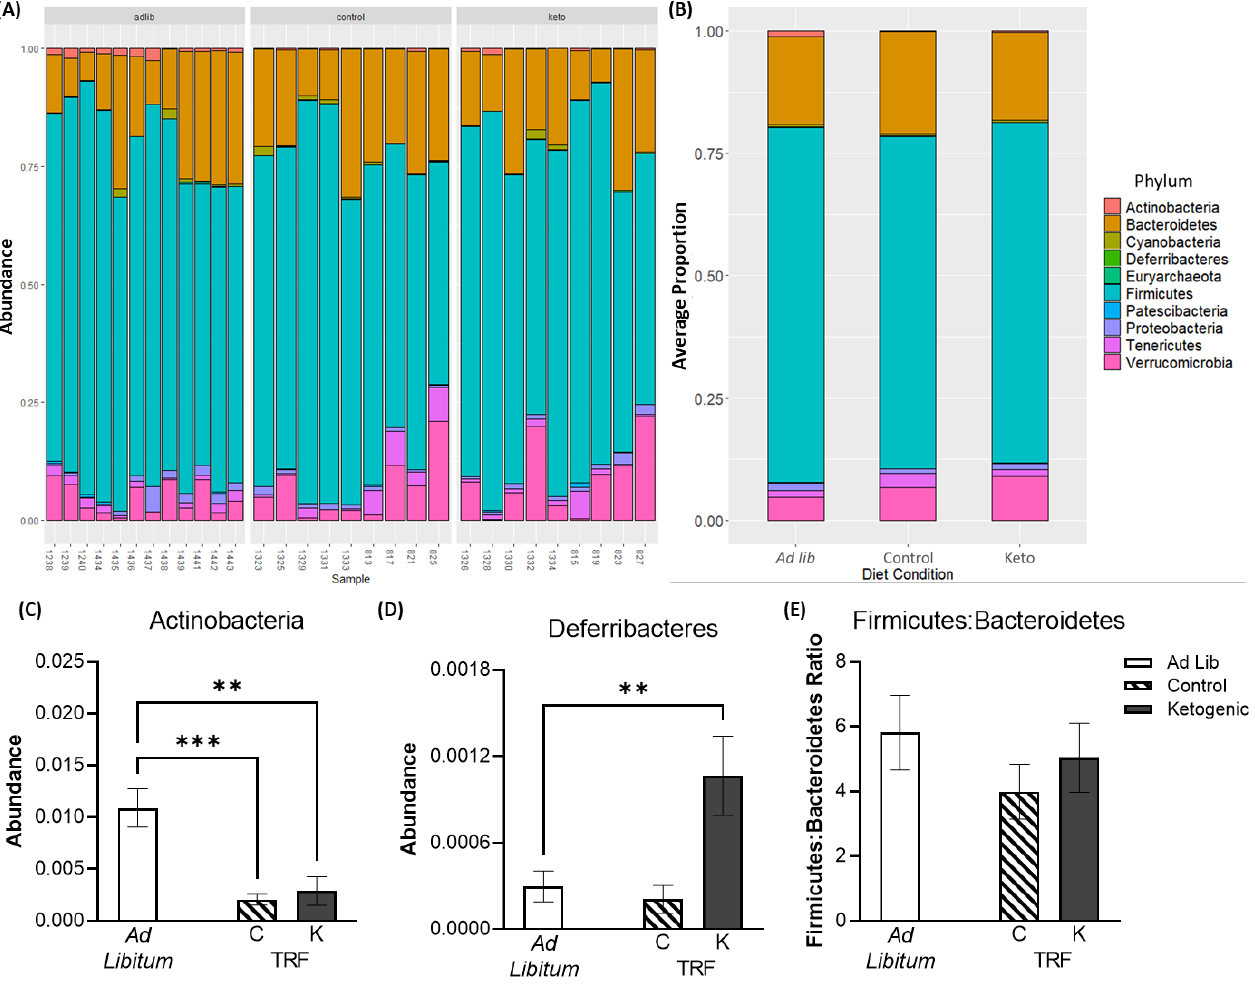
Figure 4. Relative abundance at the phylum taxonomic level by ( A ) subject and ( B ) diet condition. Relative abundance of ( C , D ) significantly altered phyla and ( E ) the ratio of firmicutes to bacteroidetes. All data in panels ( C – E ) are group means ± 1 SEM; ** indicates p ≤ 0.01; *** indicates p ≤ 0.001 .